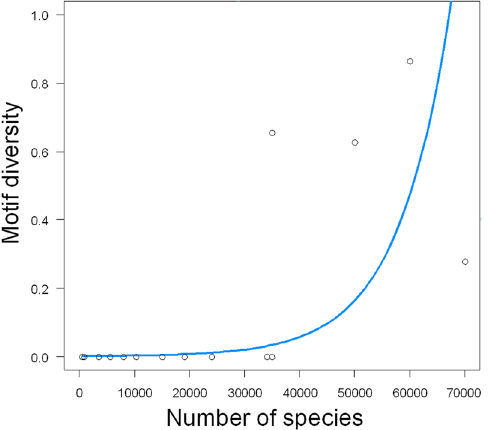
Figure 4. Relationship between motif diversity and species richness in taxa. The blue line represents the estimated model from GLS. The analysis was performed in the R environment (http:// www.r- proje ct. org/ index. html) using R version 4.1.0 23